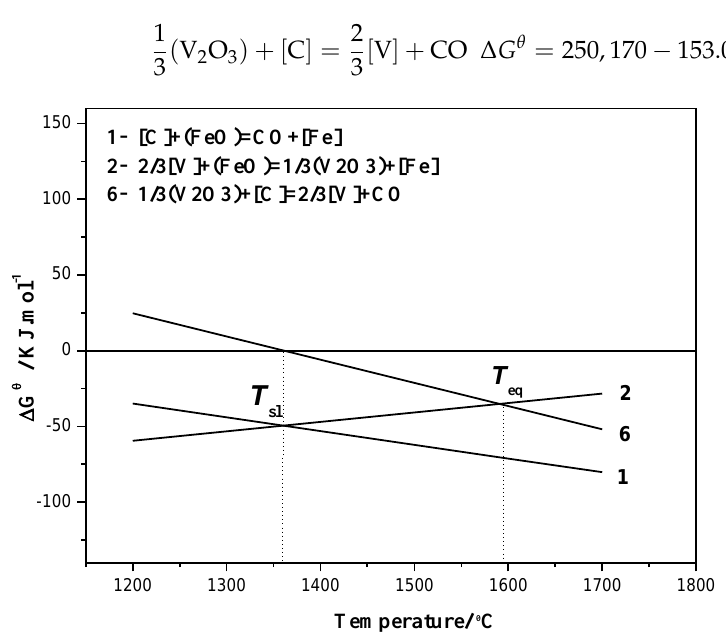
Figure 3. Relationship between Δ G θ and temperature.